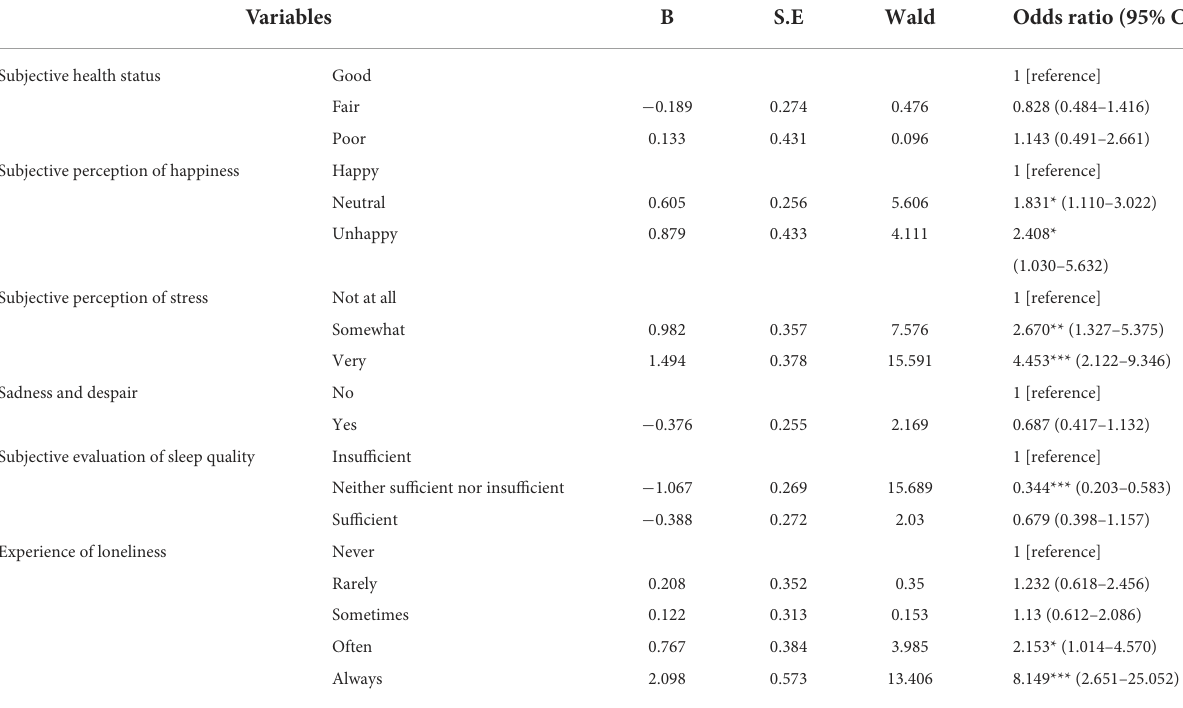
TABLE 3 Multinomial logistic analysis results in the mental health variables of the smartphone overdependent